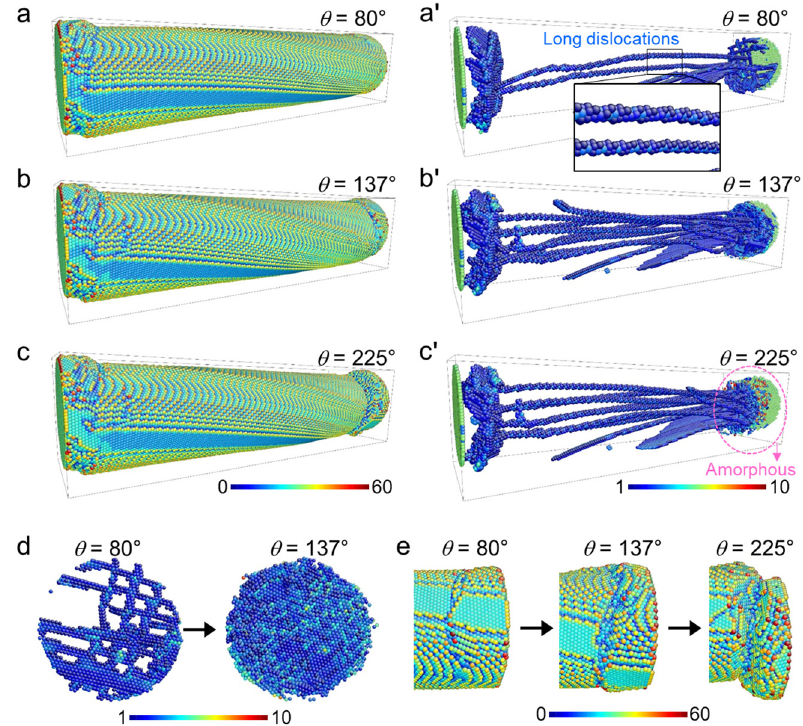
Figure 2. Typical atomic configurations during the torsion deformation of a pristine α -Fe nanowire with diameter of 10 nm and length of 45 nm at 1 K. The atomic configuration at the beginning of region A is shown in ( a ), and the corresponding dislocation structure is shown in ( a’ ). The atomic configuration at the beginning of region B (also the end of region A) is shown in ( b ), and the corresponding dislocation structure is shown in ( b’ ). The atomic configuration at the end of region B is shown in ( c ), and the corresponding dislocation structure is shown in ( c’ ). The evolution of dislocations near the wire ends is shown in ( d ). The increase of the local amorphization near the loading end with increasing twist angle is shown in ( e ). The colors are coded by the centrosymmetry parameter [34] .